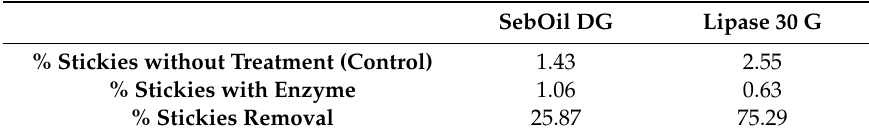
Figure 6. Stickies in paper using the rhodamine method. ( a ) No enzyme added; ( b ) treated with Lipase 30 G at 0.44 g/L. Large stikies are denoted by an arrow. Table 5. Mean stickies removal for treatments with the commercial enzymes at 0.44 g/L, measuring stickies in paper gravimetrically.